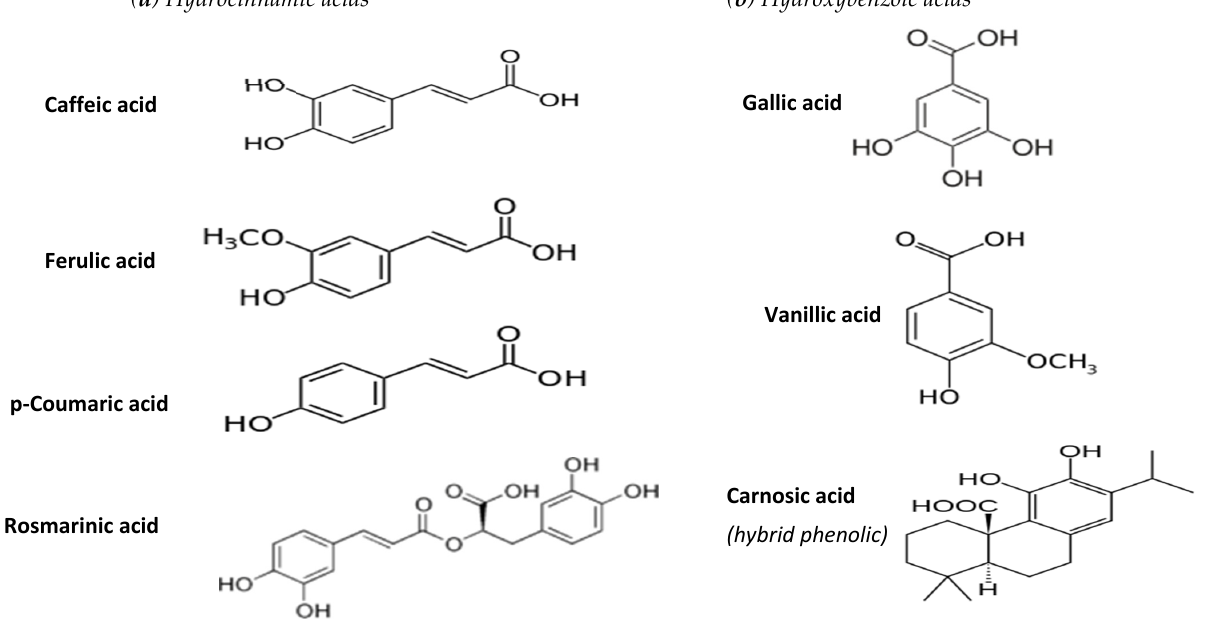
Figure 1. Chemical structure of phenolic acids examined in this